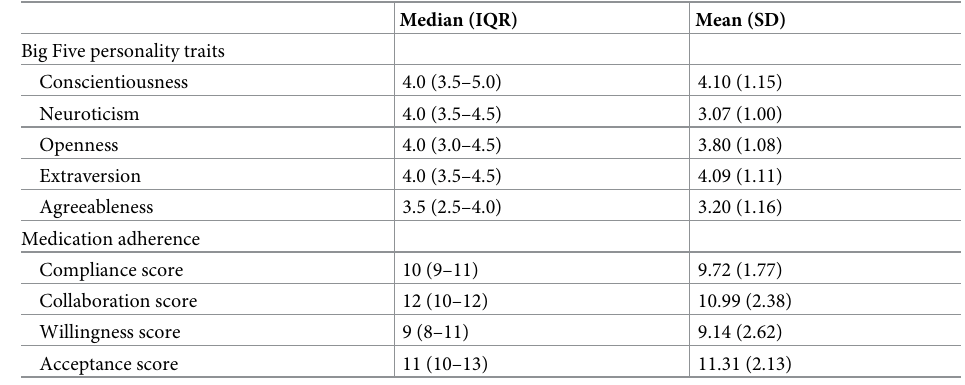
Table 2. Distribution of Big Five personality traits and medication adherence scores.